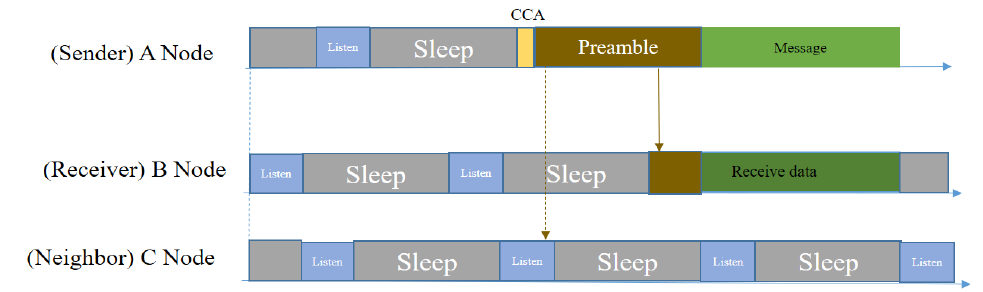
Figure 5. Packet transmission in B-MAC [28].